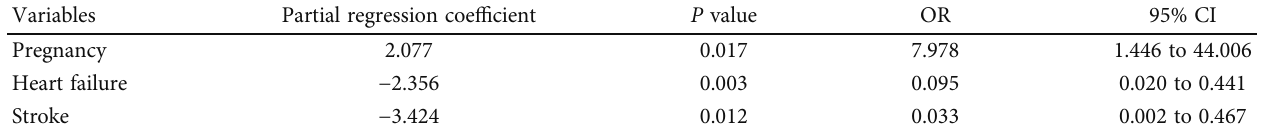
Table 7: Risk factors for